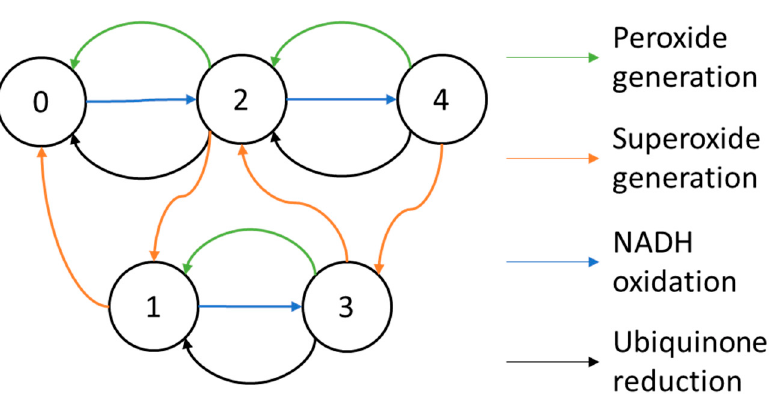
Figure 5. Schematic of the complex I model by Bazil et al. [61]. The 5 states represent the number of electrons held by complex I. The model includes peroxide generation reactions (green arrows) taking two electrons from complex I to oxygen, superoxide generation reactions (orange arrows) taking one electron from complex I to oxygen, NADH oxidation reactions (blue arrows) taking two electrons from NADH to complex I, and finally ubiquinone reduction reactions (black arrows) taking two electrons from complex I to ubiquinone, coupled with 4-proton translocation. The figure was reprinted/adapted with permission from Ref. [61].